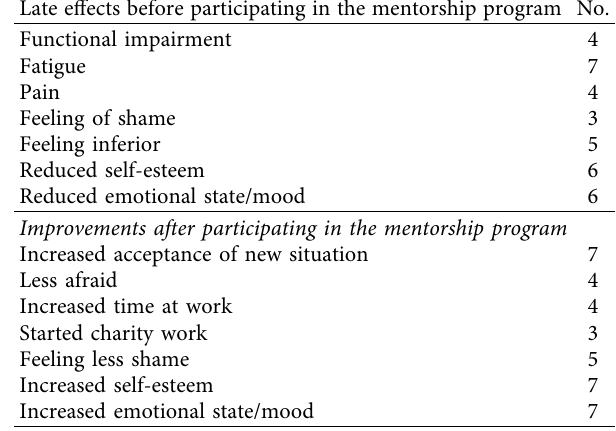
Table 1: Mentees’ demographic information and disease charac- teristics ( N � 7). Demographic and disease